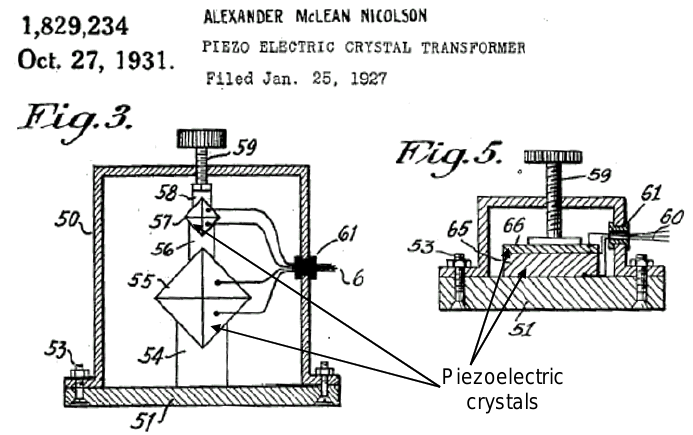
Figure 1. Representative sketch of the work of Alexander Mclean Nicolson on piezoelectric crystal transformers [1].